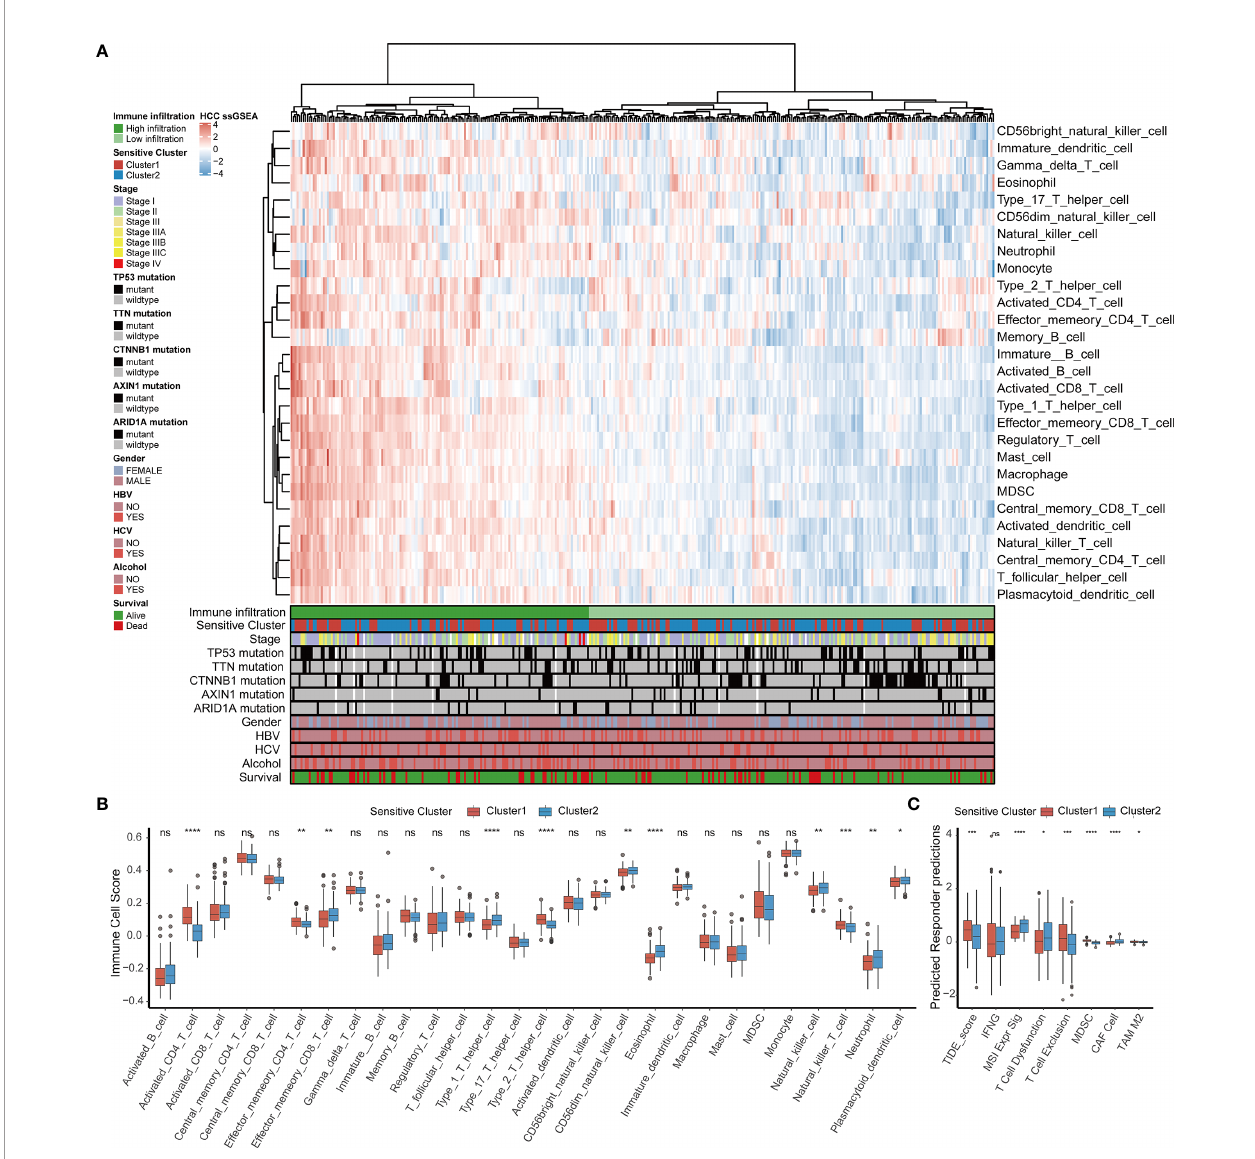
FIGURE 3 | TME immune cell in fi ltration characteristics and immune components in distinct TTK patterns. (A) Heatmap showing the unsupervised clustering of TCGA-LIHC cohort using the ssGSEA score based on 28 immune cell subpopulations. Survival status, alcohol use, hepatitis C or B virus infection, sex, ARID1A mutation, AXIN1 mutation, CTNNB1 mutation, TTN mutation, TP53 mutation, stage, and sensitive cluster are annotated in the lower panel. (B) Relative abundance of each in fi ltrating cell type that differed between the two clusters. (C) Box plots showing the TIDE score for the two clusters in HCC. The upper and lower ends of the boxes indicate the interquartile range. Lines in the boxes indicate median values, and black dots show outliers. * p < 0.05; ** p < 0.01; *** p < 0.001; **** p < 0.0001; ns, no statistical signi fi